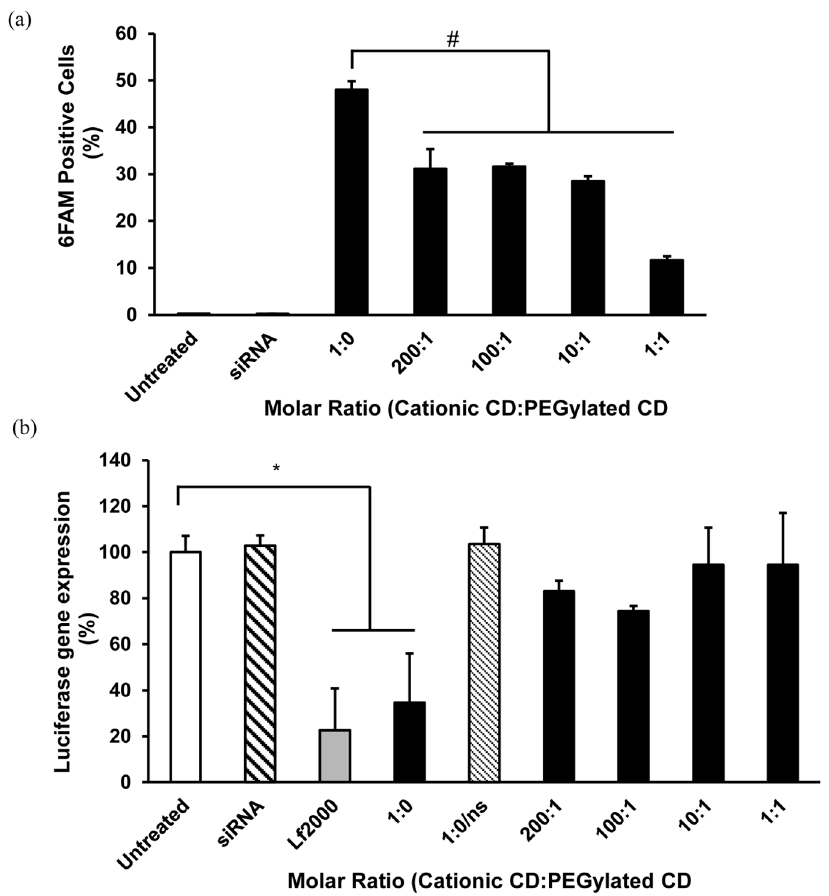
Figure 4. Internalisation and transfection of neuronal cells by CDs. (a) Uptake and (b) Gene knockdown by CD.siRNA complexes in mHypoE N41 cells by co-formulated CD.siRNA complexes (siRNA 50 nM). (a) Complexes were applied for 24 hours before measuring uptake by flow cytometry. Uptake was expressed as percentage of fluorescent siRNA positive cells. (b) Cells were incubated with pGL3-luc complexed to Lf2000 for 3 hours, then CD.siRNA complexes were applied for 24 hours before assessing for luciferase expression. Luciferase expression was calculated as a percentage of untreated cells. Data are presented as mean 6 SEM (n=3). * p , 0.05 relative to untreated cells. (1:0/ns contains non-silencing siRNA and is included as a